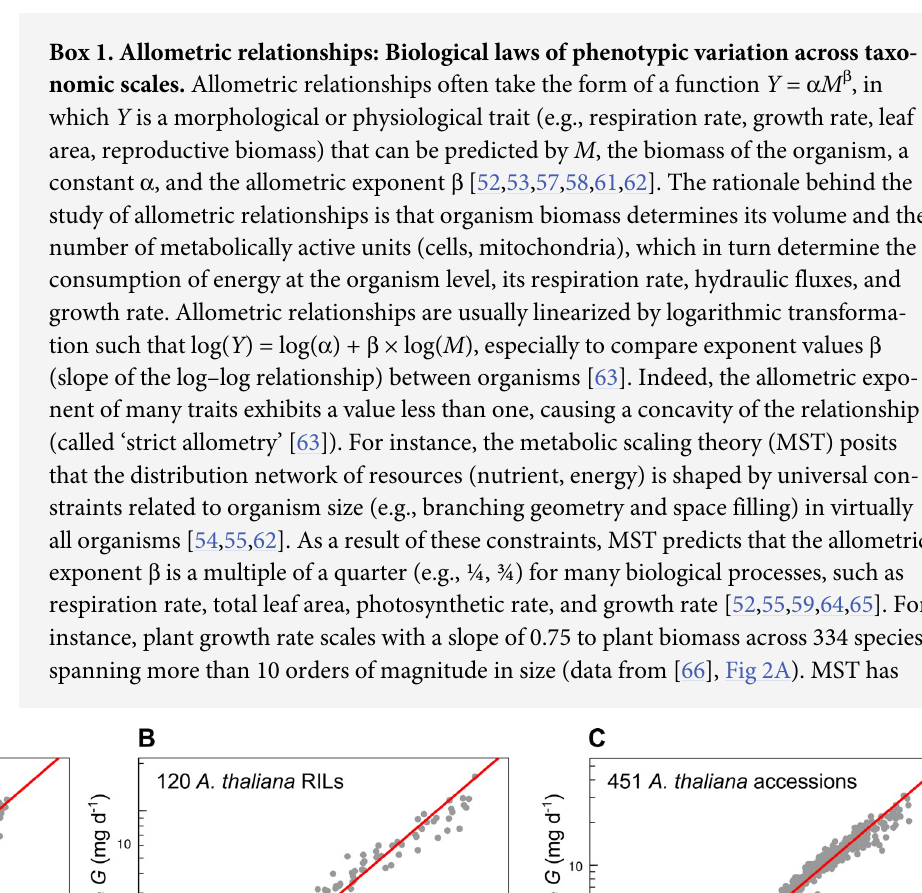
PLOS Biology | https://doi.org/10.1371/journal.pbio.3000214 April 24,